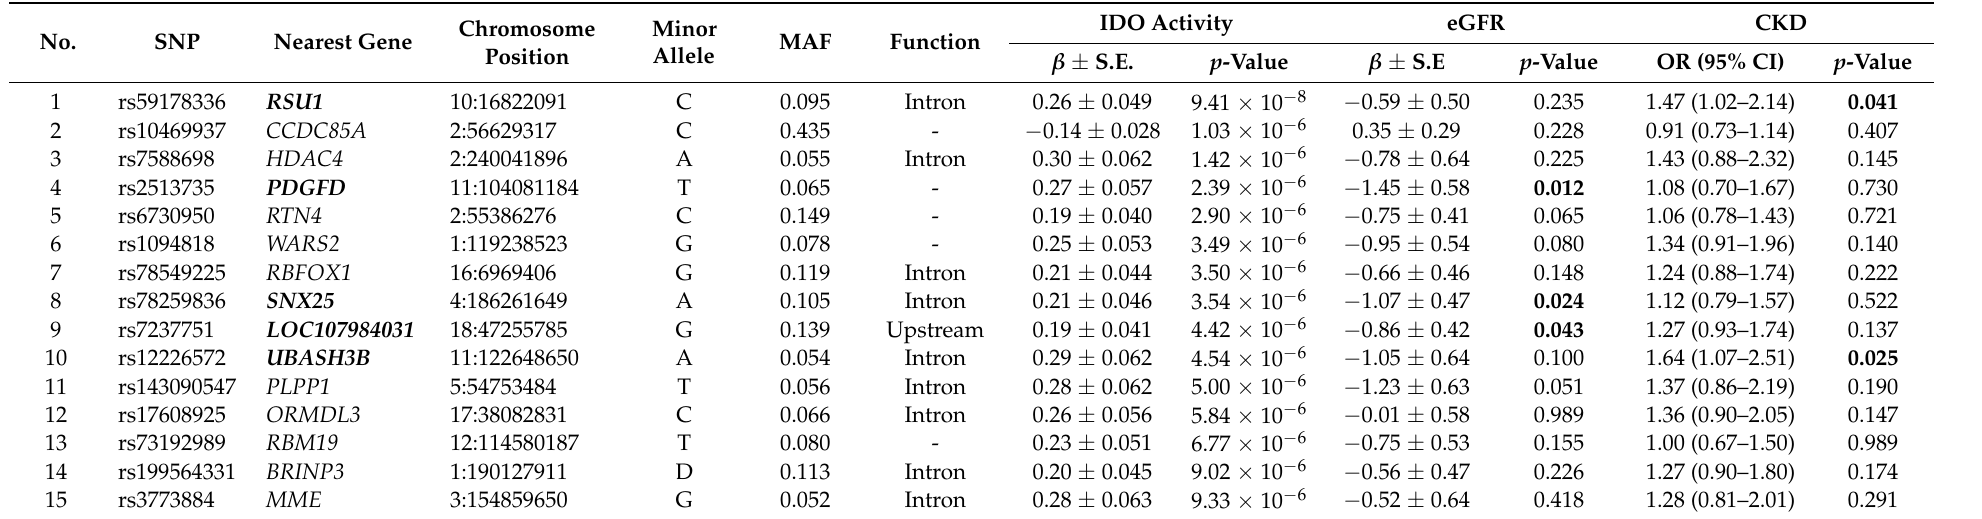
Table 2. Common variants associated with indoleamine 2,3-dioxygenase activity in Koreans.